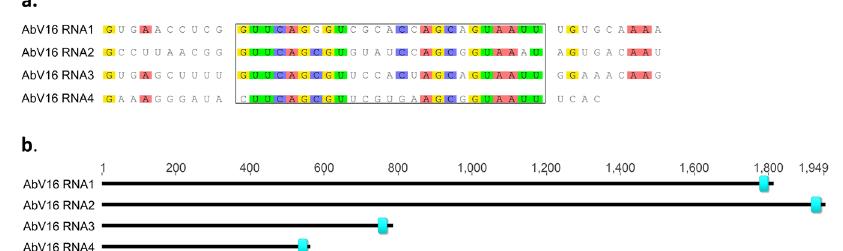
Figure 4. The motif sequence and location shared by the AbV16 RNAs ( a ) Alignment of the motif observed in the 3 ′ UTR of the AbV16 RNAs which are associated with the Brown Cap Mushroom Disease. The nucleotides within the box define the shared motif with probabilities of; 4.87 × 10 − 13 , 1.0 × 10 − 12 , 1.36 × 10 − 14 and 1.07 × 10 − 12 for RNAs 1–4 respectively. ( b ) The location of the motif within each RNA molecule. Scale is length in bases.